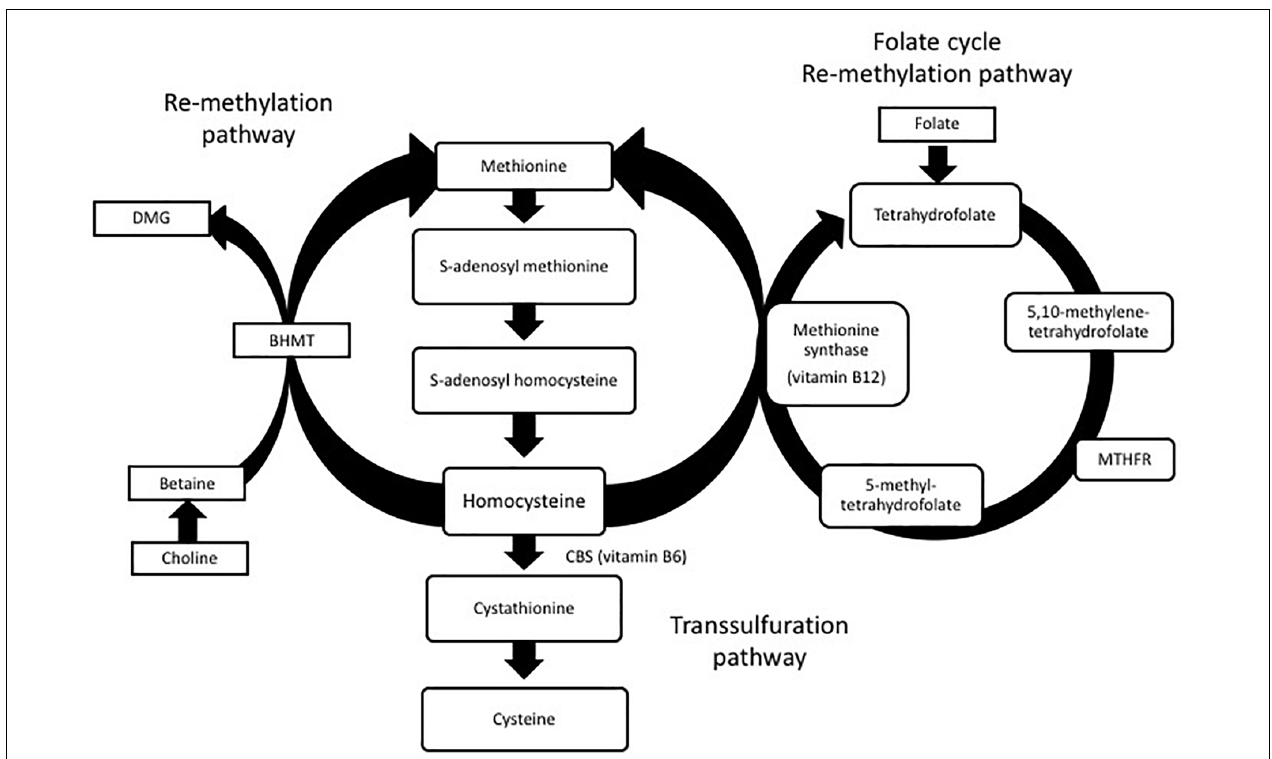
FIGURE 1 | Homocysteine metabolism: homocysteine is converted to methionine or cysteine via remethylation or transsulfuration pathways. Dimethylglycine (DMG), betaine-homocysteine S -methyltransferase (BHMT), methylenetetrahydrofolate reductase (MTHFR).